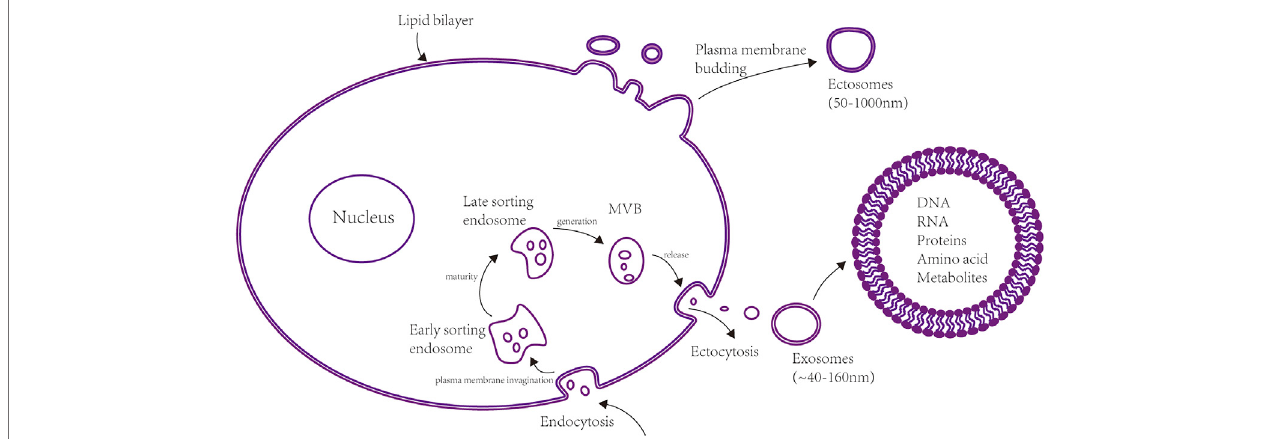
FIGURE1| Formation mechanismsoftwotypesofextracellularvesicles(EVs).Ectosomesandexosomesaretwosigni fi cantclassi fi cationsofEVs.Ectosomesare formed by plasma membrane budding, and their diameter range from ~50 to 1,000 nm. Exosomes range from ~40 to 160 nm and originate in the endosomal pathway viatheformationofearly-sortingendosomes(ESEs),late-sortingendosomes(LSEs),andultimatelymultivesicularbodies(MVBs).ExosomesareformedwhenMVBsare released by ectocytosis. The exosome population in cells can be highly heterogeneous. Exosomes exhibit different abilities to produce complicated biological responses in recipient cells depending on their cellular origins and speci fi c content (e.g., amino acids, proteins, lipids, metabolites,